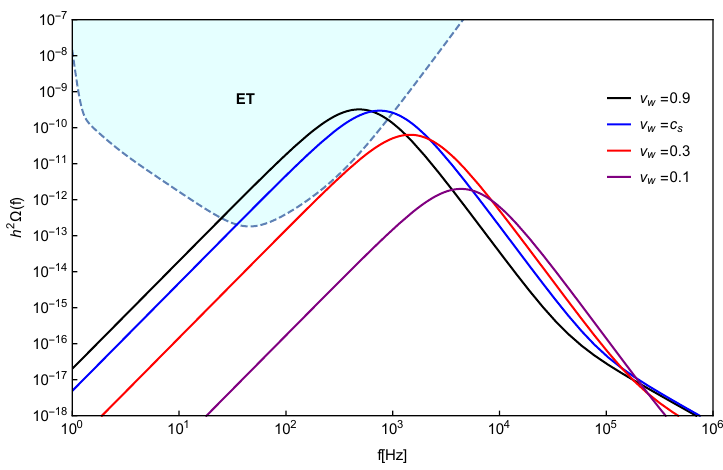
Figure 4 . GW energy density spectra of the first order PQ PT with f a = 100 PeV for different bubble wall velocities and combustion regimes are displayed. For v w = 0 . 9 , we use eq. (4.22) for the efficiency factor. The dashed curve is the approximate prospective sensitivity curve of ET [56,